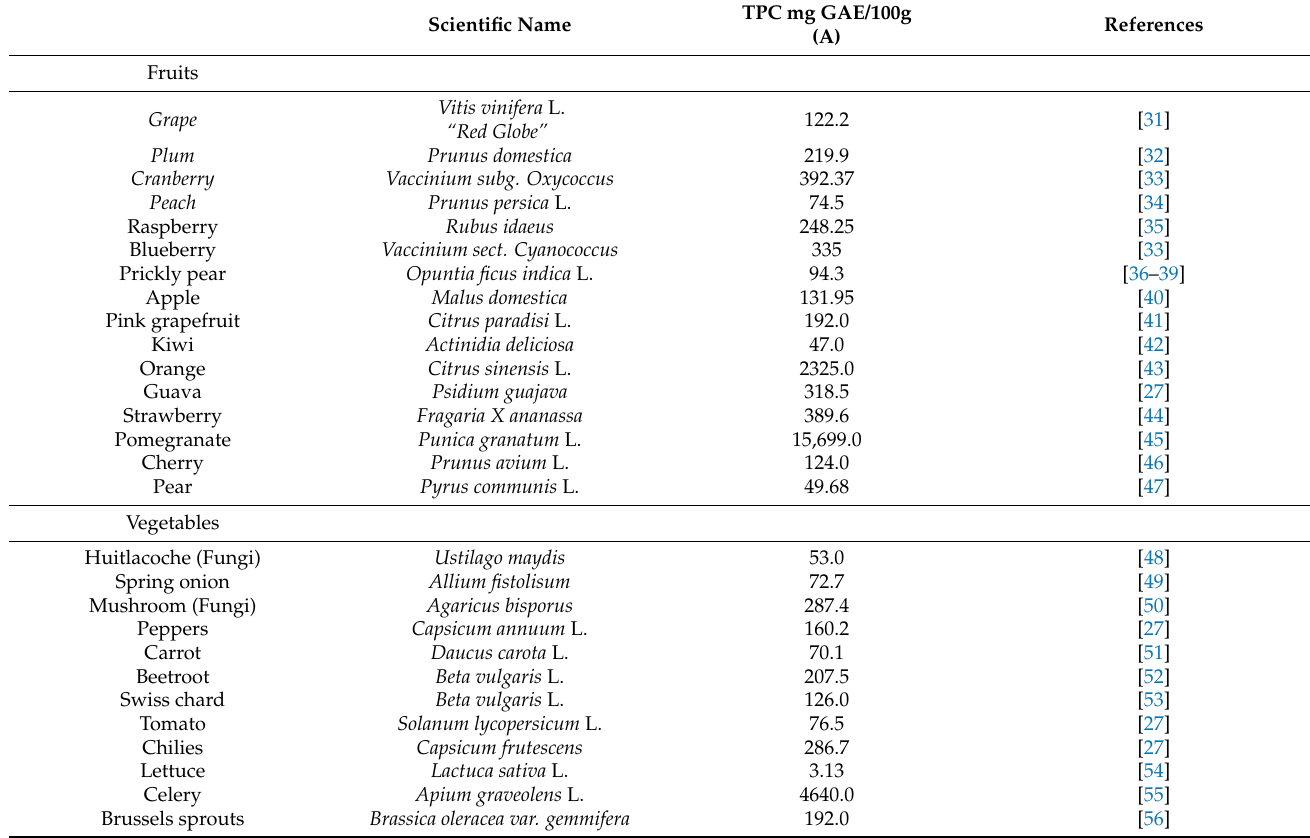
Table 1. Total phenolic compounds (TPC) of each